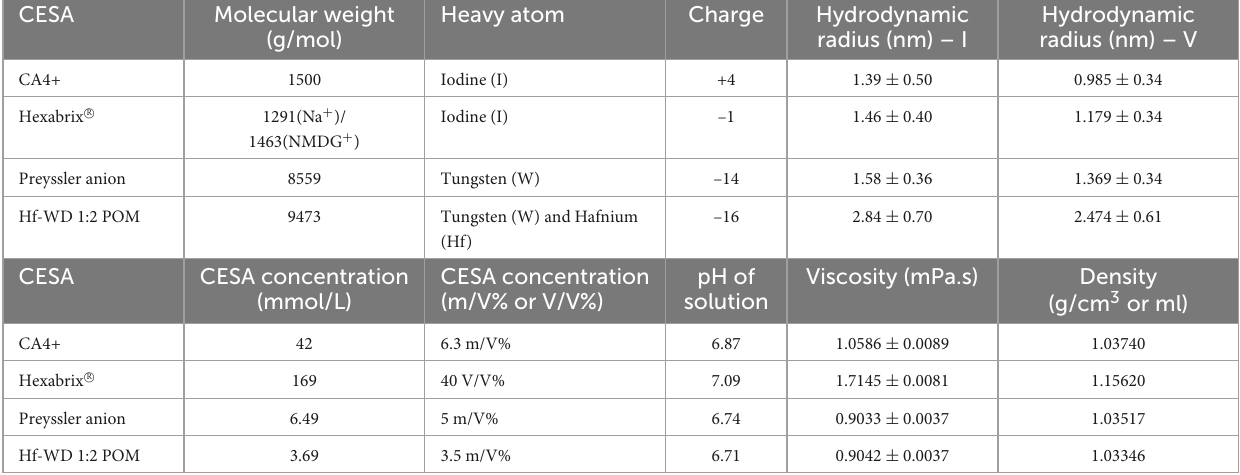
TABLE 1 Overview of the properties of the CESAs and their respective staining solutions. CESA Molecular weight